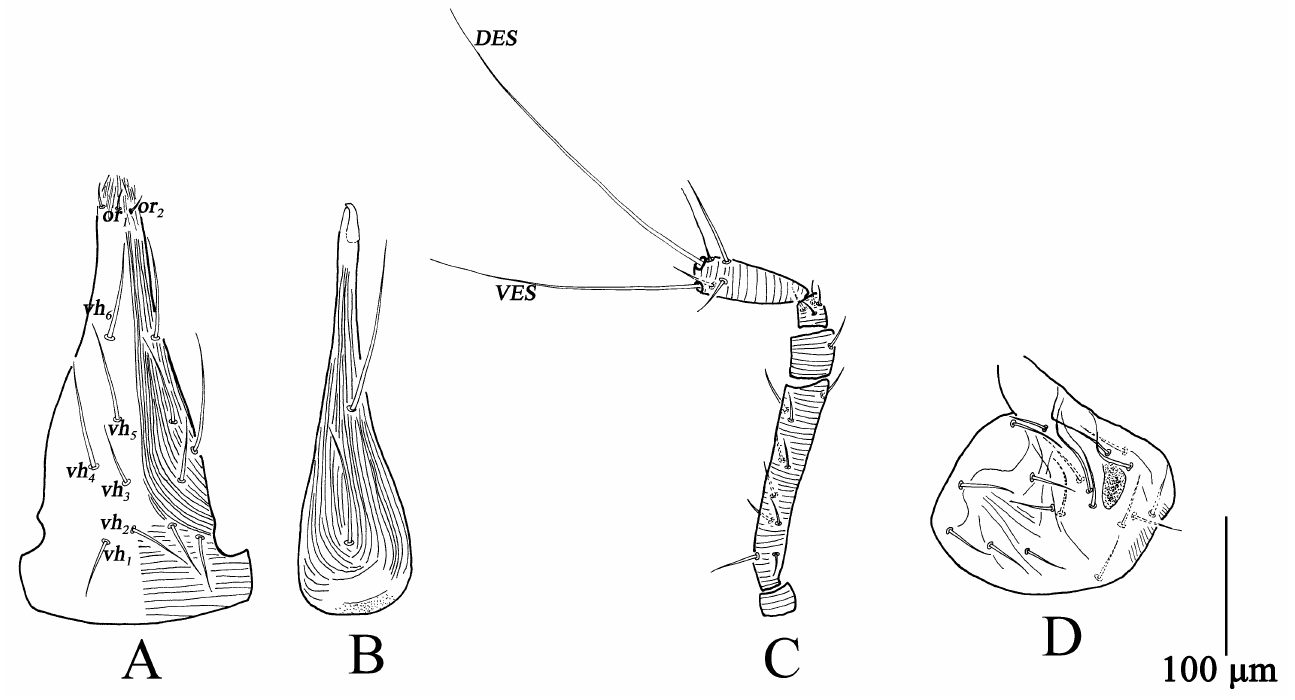
Figure 1. Bdella muscorum , female: (A ) Subcapitulum; (B ) Chelicera; (C ) Palp; (D ) Ovipositor. Dorsu m (Figure 2A). Prodorsum with transverse striae, prodorsal apodeme reticu- lated between at and pt , anterior region of prodorsum with elongated chamber. Two pairs of lateral eyes, the anterior one 23 – 25; the posterior one 20 – 24. Hysterosoma with broken or continuous striae; with three cupules ( ia , im and ip ) at the level of setae d 1 , e 1 and be- tween f 1 ; all dorsal setae smooth. Measurements of dorsal setae as follows: at 154 – 201, pt 184 – 256, lps 51 – 68, mps 85 – 114, c 1 87 – 119, c 2 122 – 133, d 1 73 – 88, e 1 70 – 88, f 1 68 – 85, f 2 72 – 97, h 1 87 – 104, h 2 72 – 83. Venter (Figure 2B). Broken striae longitudinal between coxae I – II and III – IV, and transverse between coxae II – III. Aggenital region with 11 pairs of setae ( ag 1 – 11 ); genital valves with eight pairs of setae ( g 1 – 8 ); three pairs of genital papillae; anal region with three pairs of postanals ( ps 1 – 3 ) and three pairs of anal setae ( ad 1 – 3 ) (Table 1). Ovipositor (Figure 1D). With 12 dorsal and seven ventral setae. Table 1. Changes of chaetotaxy in different stages of Bdella muscorum. Stage